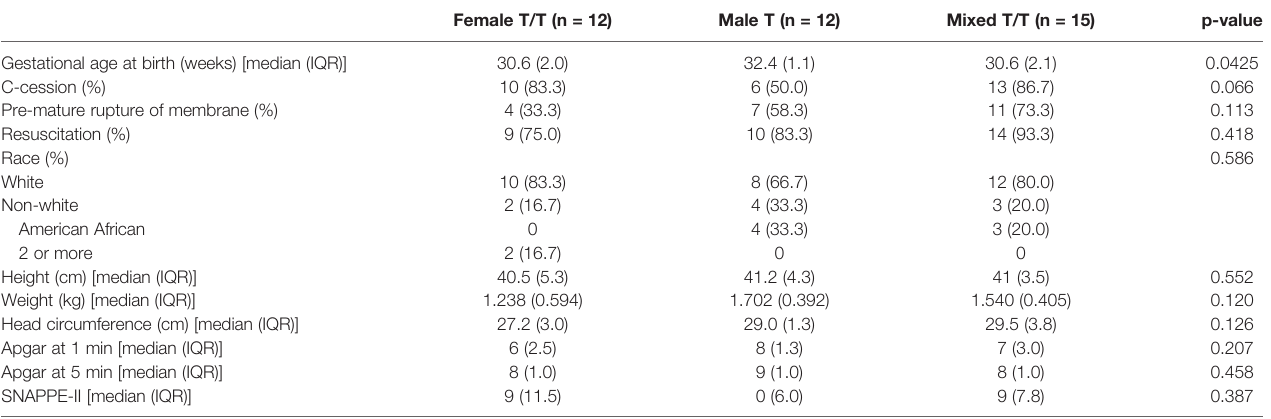
TABLE 1 | Demographic information and clinical characteristics of preterm twins/triplets